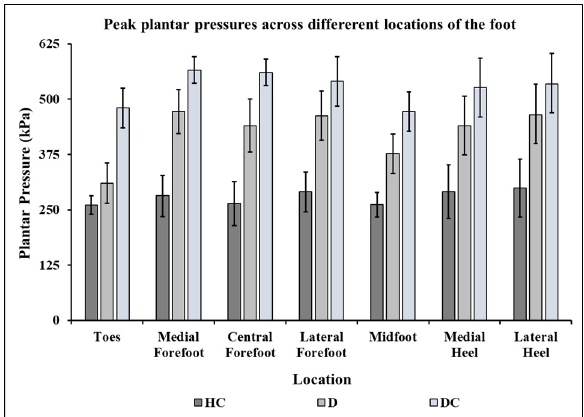
Figure 9. Peak plantar pressure at different locations of the foot across each group.